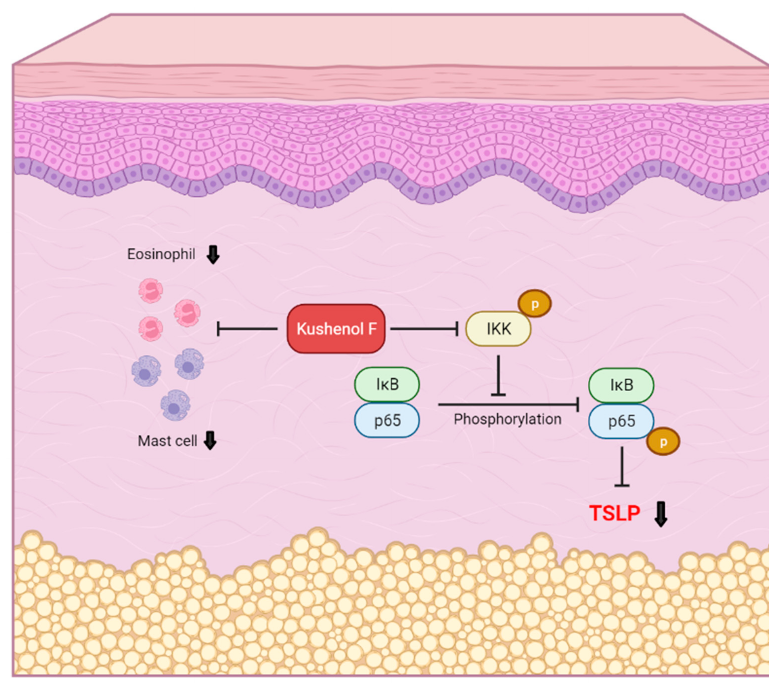
Figure 7. Summary diagram of kushenol F signaling pathway of this study.